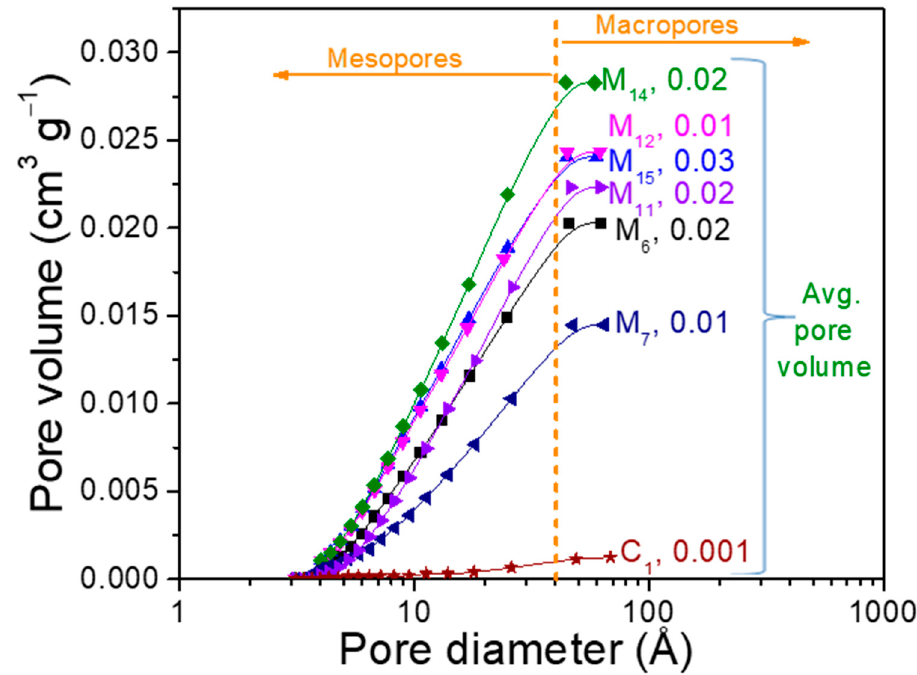
Figure 6. Comparison of the accumulative pore volume versus pore size for the samples evaluate as substrates.